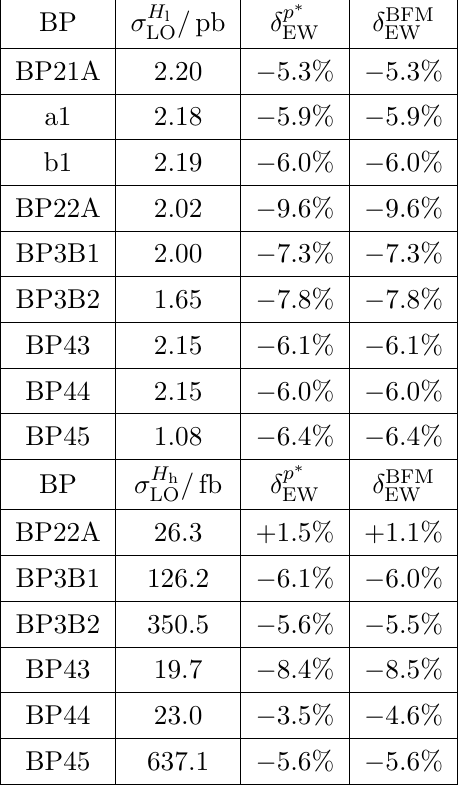
EW to Higgs-boson production in VBF pp ! H l =H h jj in the . The SM EW correction to (cid:27) H l LO